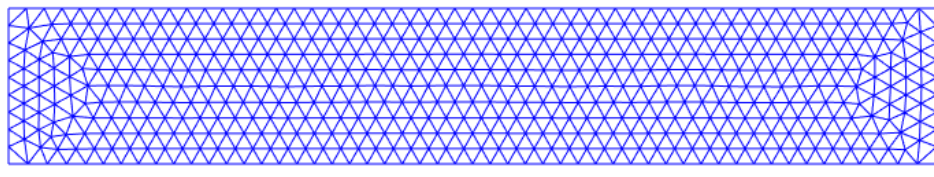
Figure 12. Part with uniform infill density of 41%.